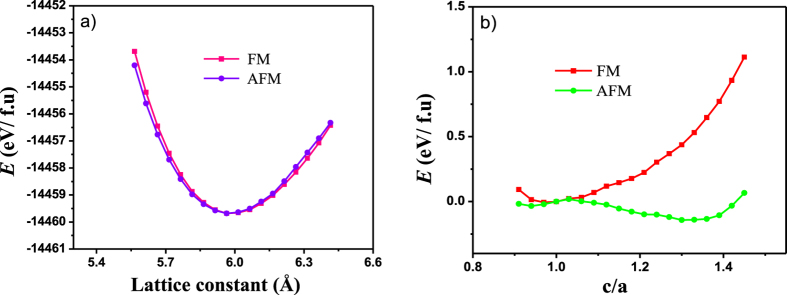
(a) Equation of states of Ni1.75Fe0.25Mn1.5Sn0.5 cubic phases for both parallel and antiparallel magnetic interactions. (b) The total energies E of Ni1.75Fe0.25Mn1.5Sn0.5 with a variation of the tetragonal ratio c/a.